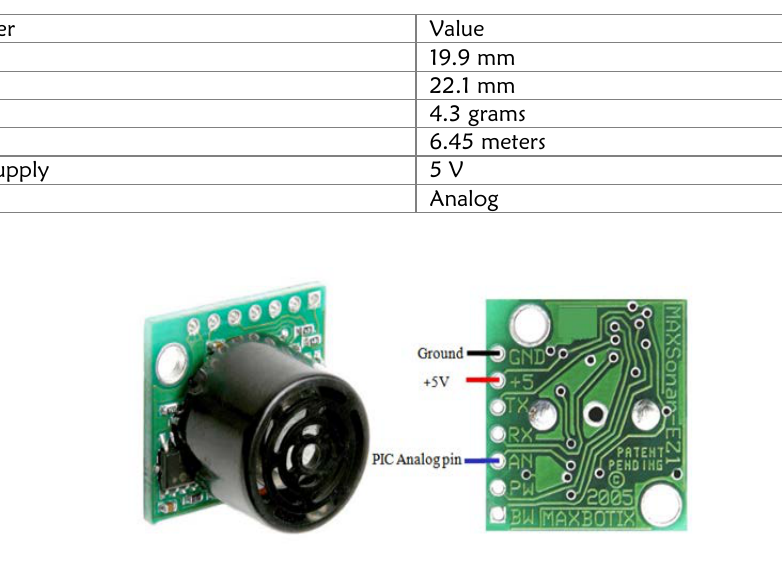
Table 1: The Maxsonar-EZI sensor specification